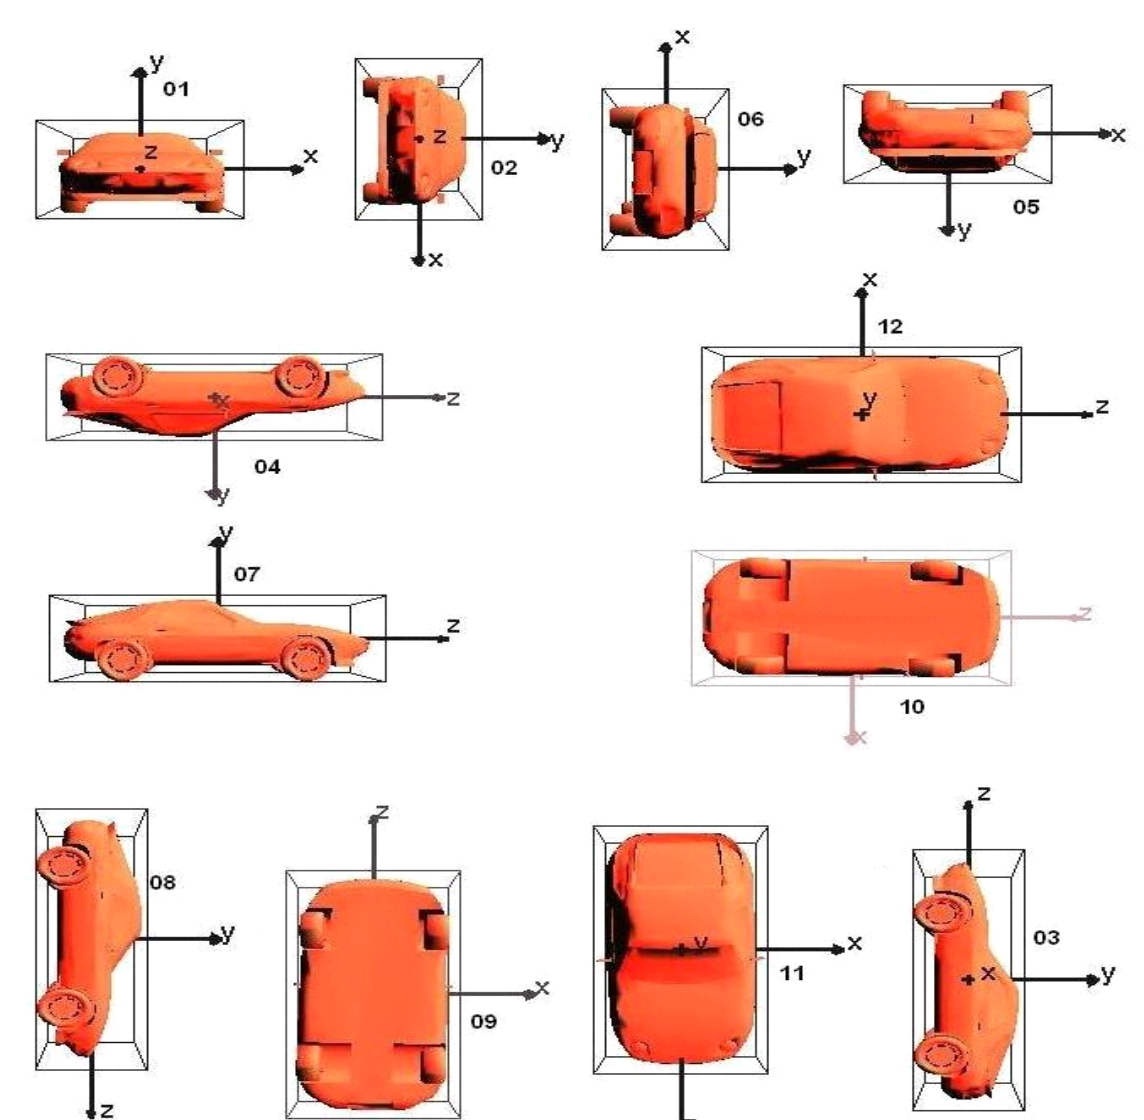
Figure 4. Hand Approach Planes Corresponding to Primitive Task